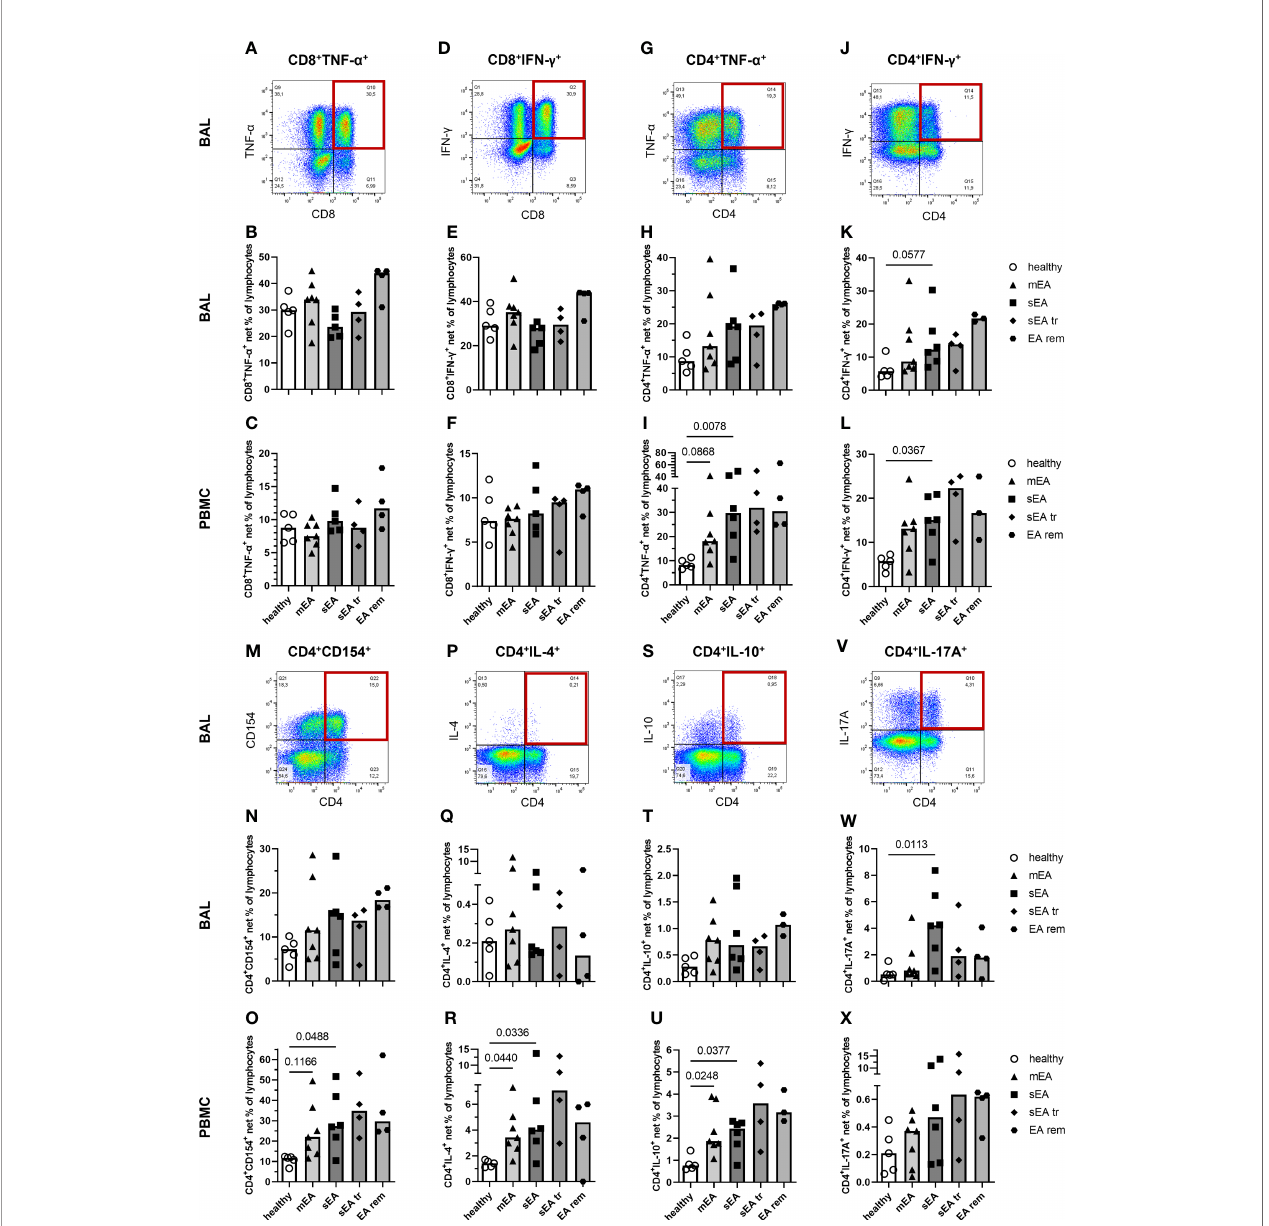
FIGURE 7 | In vitro stimulated T cells indicate a local Th17 bias during severe equine asthma and broad Th cell activation in asthmatic horses ’ PBMC. Representative plots with quadrant gates on singlet live lymphocytes after stimulation with PMA and ionomycin are shown for BAL from one horse with severe equine asthma (sEA) (A, D, G, J, M, P, S, V) . CD8 + , or CD4 + lymphocytes expressing TNF- a , or IFN- g , and CD4 + lymphocytes expressing CD154, IL-4, IL-10, or IL-17A are displayed as medium-corrected net percentages in BAL (B, E, H, K, N, Q, T, W) and PBMC lymphocytes (C, F, I, L, O, R, U, X) . Mind the variable scales of the y-axes. Results of individual horses (total n=26) are shown with bars indicating median values (n=4 – 7 per group). Differences between groups of n ≥ 5 (healthy, mEA, sEA) with p<0.12 in Kruskal-Wallis tests are indicated by given p-values. The frequencies of CD4 + IFN- g + Th1 cells (p=0.058, K ) and CD4 + IL-17A + Th17 cells (p=0.011, W ) were higher in BAL lymphocytes from horses with sEA than from healthy horses. In PBMC, net percentages of activated Th cells were increased in sEA and mEA lymphocytes compared to healthy horses ’ cells [ I ( CD4 + TNF- a + , L ) CD4 + IFN- g + , (O) CD4 + CD154 + , (R) CD4 + IL-4 + , and (U) CD4 + IL-10 +